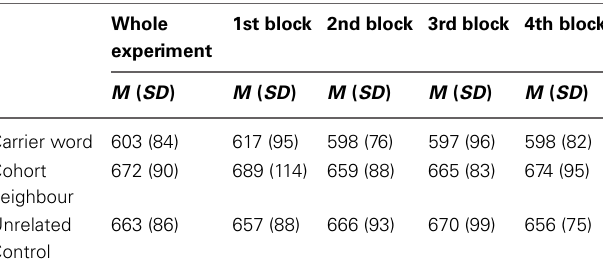
Table 1 | Mean reaction times in ms (with standard deviation) collapsed across the whole experiment (with four repetitions per target word); and separately for the first presentation (first block), first repetition (second block), second repetition (third block), and third repetition (fourth block) of the targets.